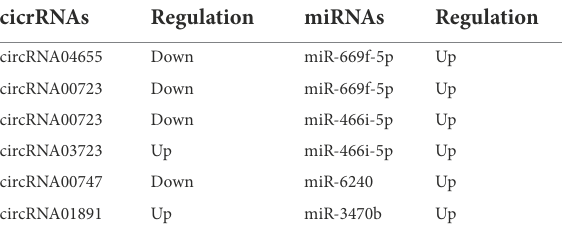
TABLE 4 Interactions of aberrantly expressed circRNAs and